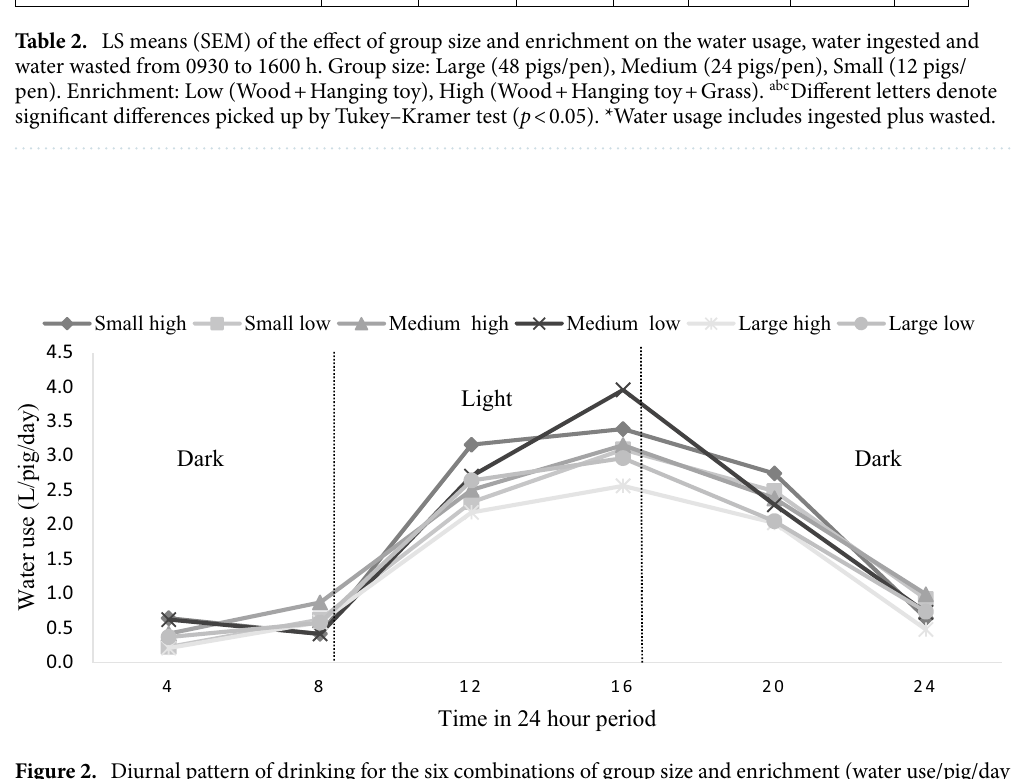
Figure 2. Diurnal pattern of drinking for the six combinations of group size and enrichment (water use/pig/day (L)) occurring during 4-h